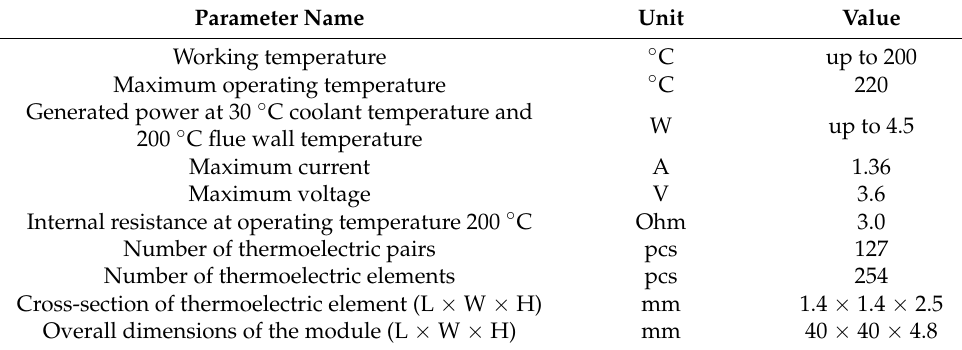
Table 3. Parameters of the operation of the thermoelectric converter modules.